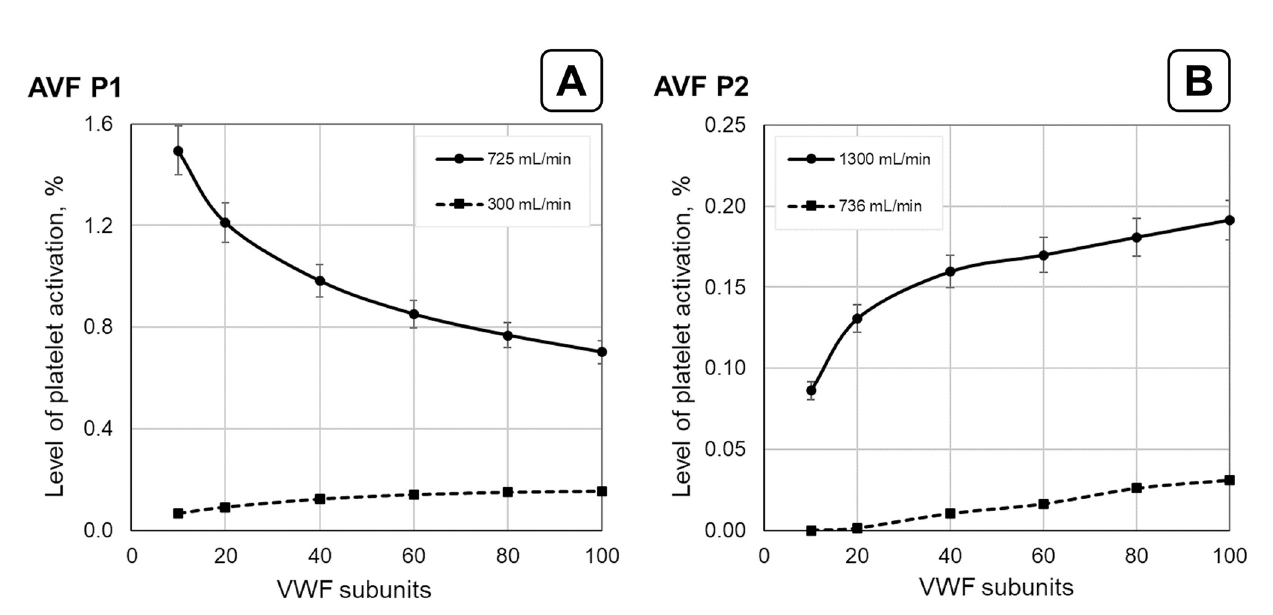
Fig 6. Dependence of the SIPAct level on the VWF multimer size in P1 (A) and P2 (B) AVFs. The results are obtained at AVF flow rates ( Q out mL/min (dashed line) and 725 mL/min (solid line) for the first patient. The first value corresponds to the minimum flow rate required for effective haemodialysis. The second value represents the maximum AVF P1 flow rate used in the calculations. The results are obtained at AVF flow rates of 736 mL/min (dashed line) and 1300 mL/min (solid line) for the second patient. The first value corresponds to the flow rate when SIPAct is absent for the lowest VWF multimer size within the considered range ( N = 10). The second value is the maximum AVF flow rate used in this work for the second patient. The solid and dashed lines are to guide the eye.